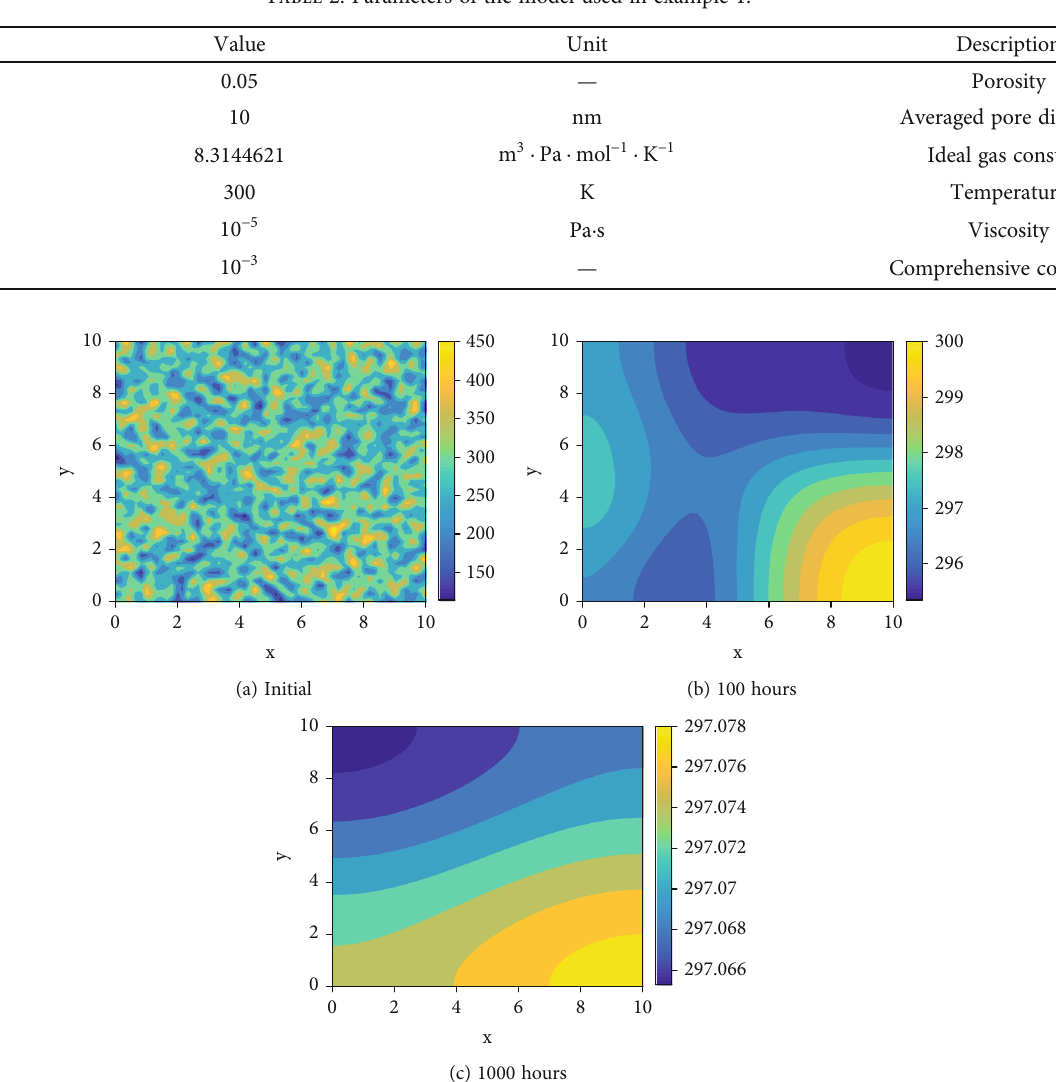
Figure 1: Gas density distributions computed by the proposed model in example 1 at di ff erent